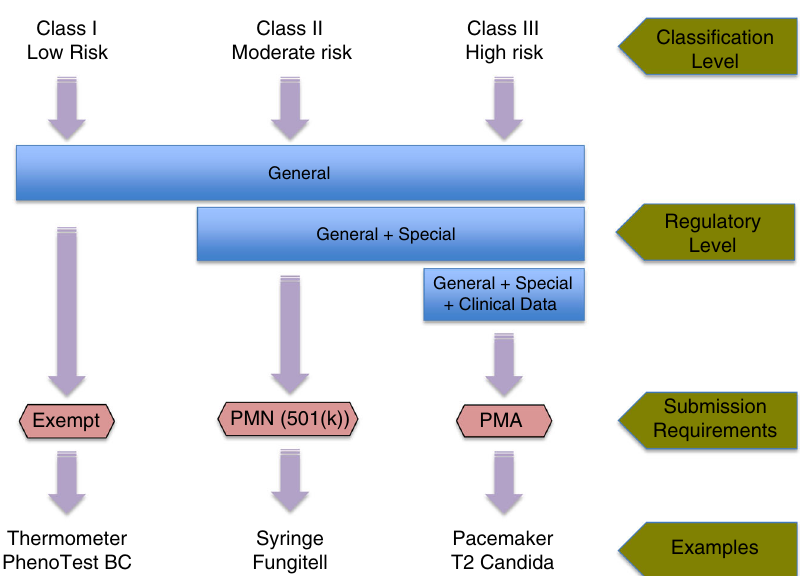
Fig. 1 FDA approval pathways for medical devices. The approval process is based on risk to patients, with higher risk requiring more regulatory control. The FDA assists in the classi fi cation process through their database, which contains almost 2000 generic medical devices organized into 16 different panels. Classi fi cation is determined in part by location of the device on the patient, duration of device contact with the patient, and whether the device will be active or passive (active devices require power, usually electrical). Class I devices are the lowest risk and most are exempt from premarket noti fi cation. The device and company must be registered with the FDA but approval is not required. Class II devices need FDA clearance through the 510(k) premarket noti fi cation (PMN) process. Class III devices need premarket approval (PMA) and usually clinical trials. Examples of fungal devices (bold) are the PhenoTest BC (Accelerate Diagnostics, Inc.), which identi fi es Candida albicans and Candida glabrata , the Fungitell assay for fungal β - D -glucan (Associates of Cape Cod, Inc.), and the T2Candida assay (T2 Biosystems, Inc.), which identi fi es fi ve species of Candida from blood